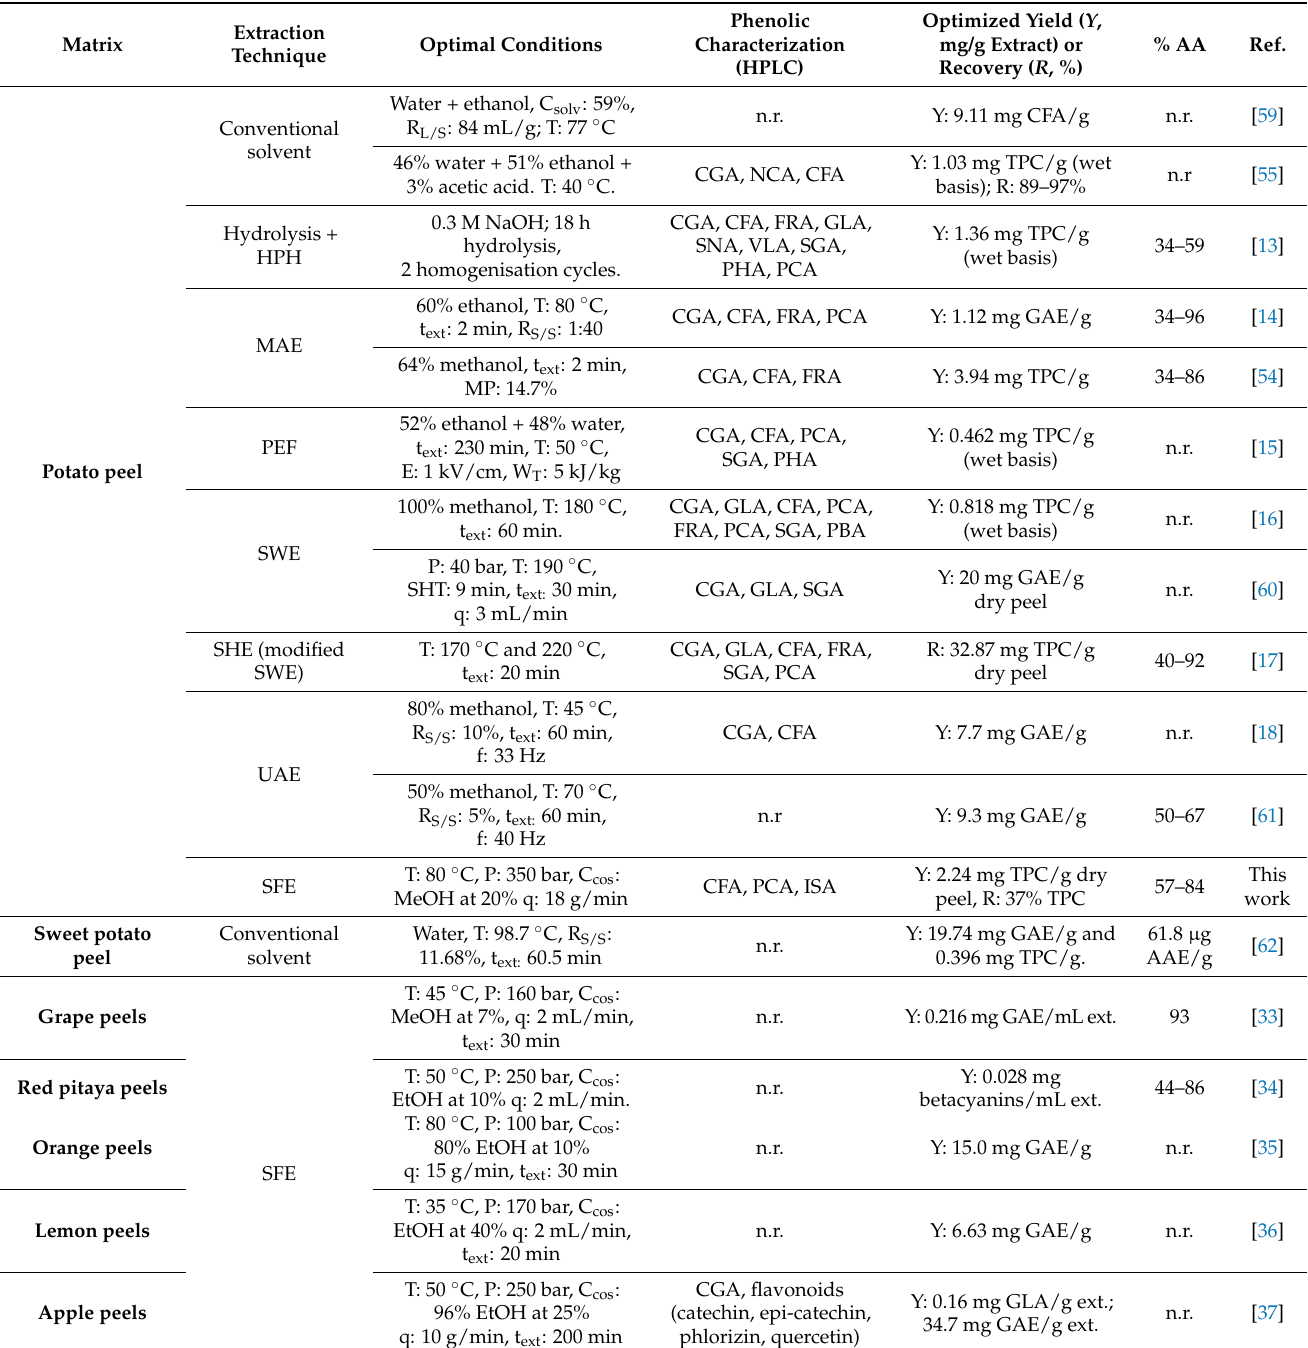
Table 7. Literature data on the extraction of phenolic acids from potato peels via different green technologies in the last decade. Extraction Matrix